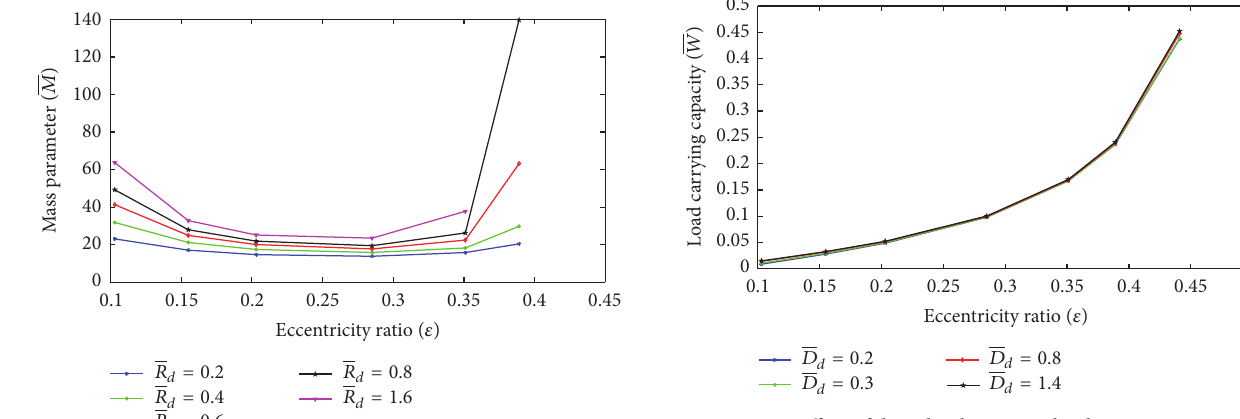
Figure 14: Effect of dam depth ratio on load carrying